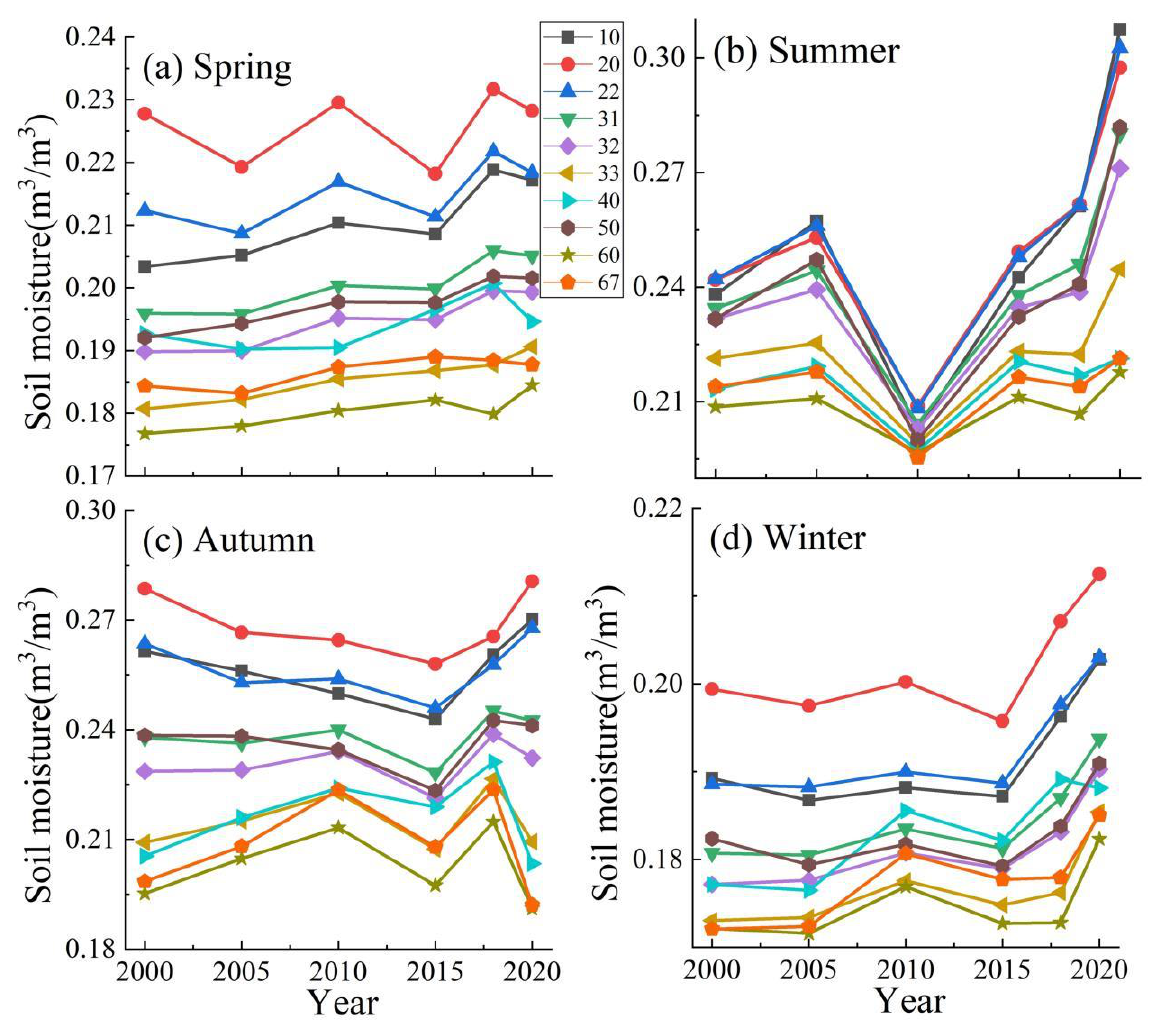
Figure 6. Seasonal SM variations in different land covers in the TP from 2000 to 2020: ( a ) spring, ( b ) summer, ( c ) autumn, and ( d ) winter, respectively. The legend numbers correspond to the land cover codes.